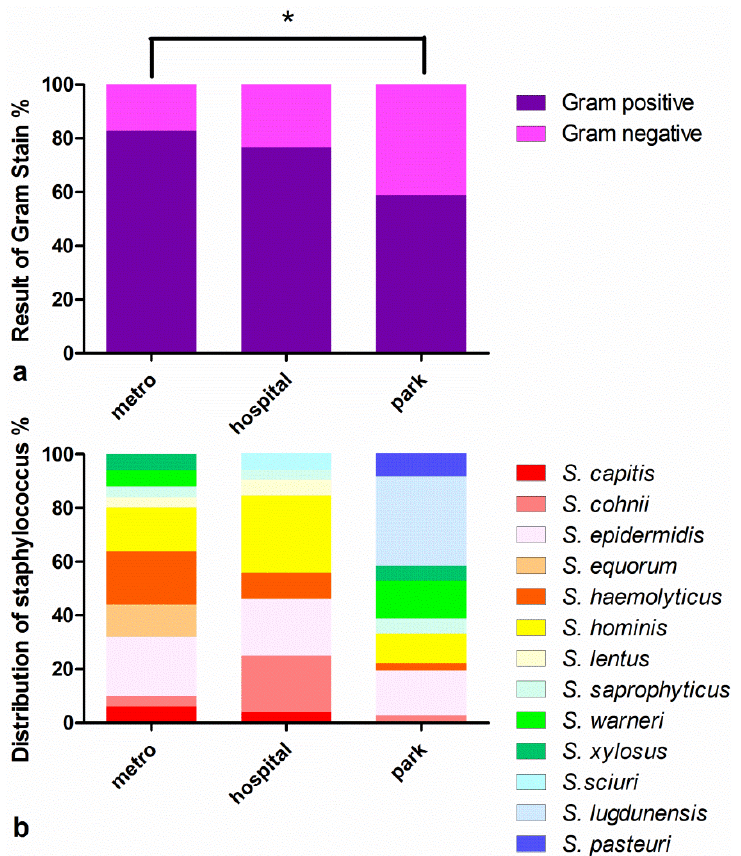
Figure 1. Distribution of strains. ( a ) The presence of Gram-positive straining in the park samples was significant lower (χ 2 test, p < 0.05) than in the samples from the metro and hospital; ( b ) The distribution of Staphylococcus in the three groups. The composition and distribution of Staphylococcus strains differed between the three